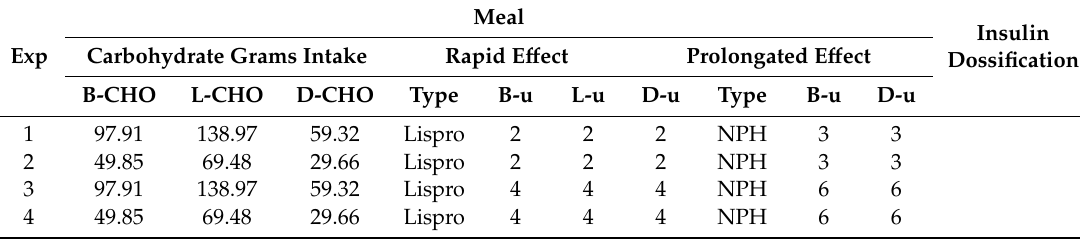
Table 3. Selected parameters set of four